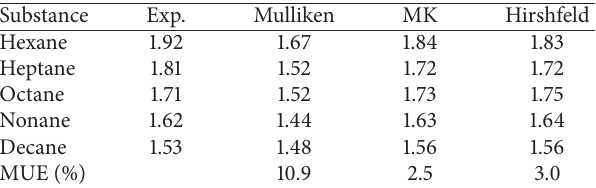
Table 2: Calculated ion mobilities of n-alkanes (clustered with one water molecule) in comparison with experimental values (all in cm 2 V −1 s −1 ). Experimental values taken from